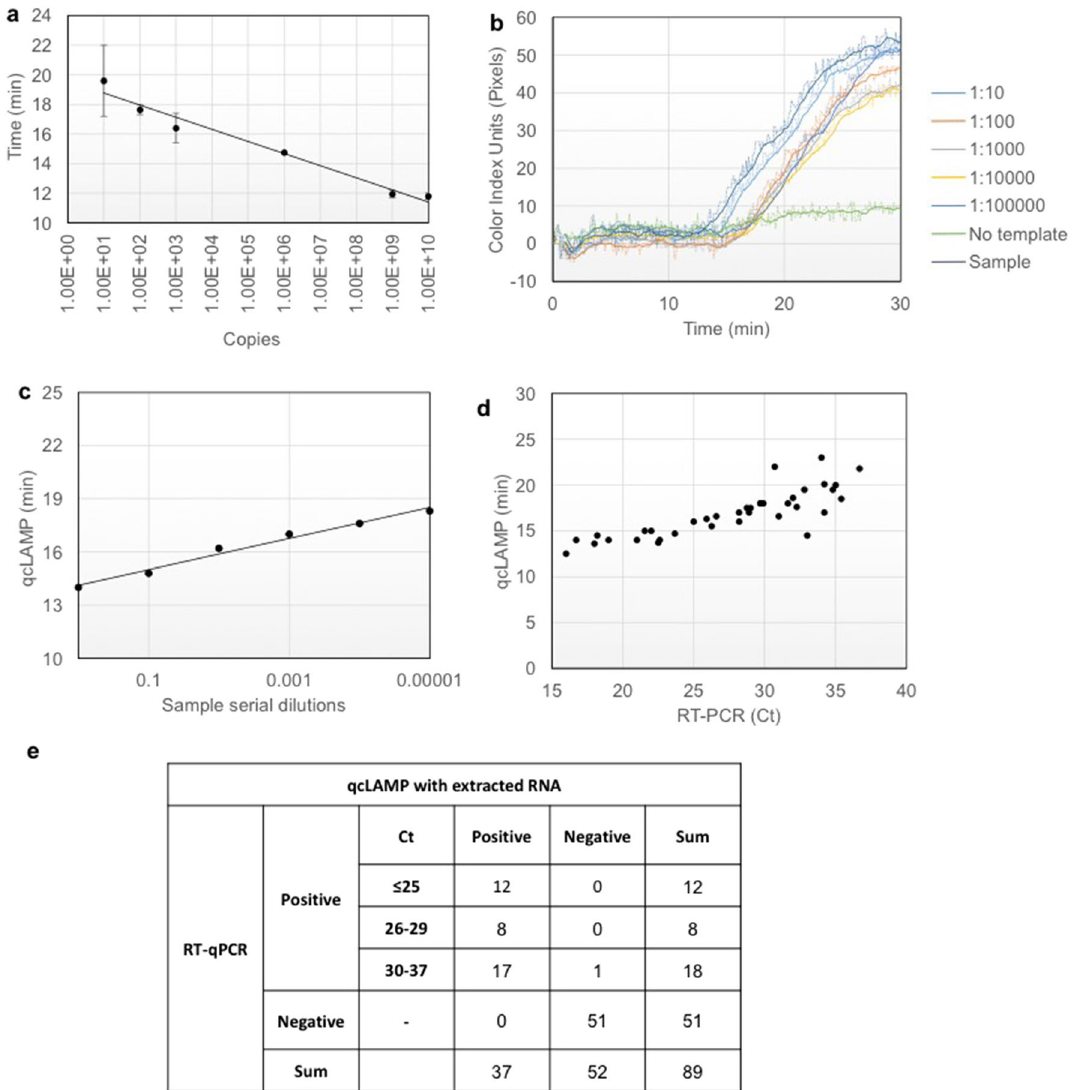
Figure 4. ( a ) Calibration curve using Influenza A DNA template ranging from 10 1 to 10 9 copies per reaction; error bars represent standard deviation of at least triplicates ( b ) Serial dilutions of a SARS-COV-2 positive sample with a reported Ct value of 19 were measured with the qcLAMP method. ( c ) Correlation (R 2 = 0.99) between the qcLAMP time-to-positive results and the viral RNA concentration based on a tenfold serial dilutions. ( d ) Scatter plot of the Ct values (ranging from 16 to ~ 37) for 38 positive samples versus the qcLAMP time-to-positive (ranging from 12.5 to 23 min). qcLAMP measurements were performed in different days within 3 weeks using stored (− 80 °C) RNA samples. Only one point was missed by qCLAMP in the first run corresponding to a Ct of 35. ( e ) Diagnostic results of SARS-CoV-2 qcLAMP assay-evaluation with 89 clinical samples including 38 COVID-19 positive and 51 negative. An overall sensitivity of 97% (95% CI: 93–100), specificity of 100% and negative likelihood ratio of 0.026 (95% CI: 0.004–0.182) were